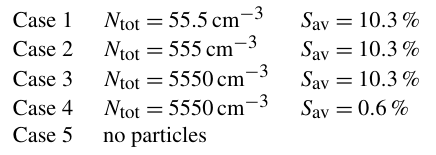
Table 1. The summary of key parameters for studying the effect of total number of particles on air temperature, supersaturation and activation. S av is initial supersaturation averaged over the